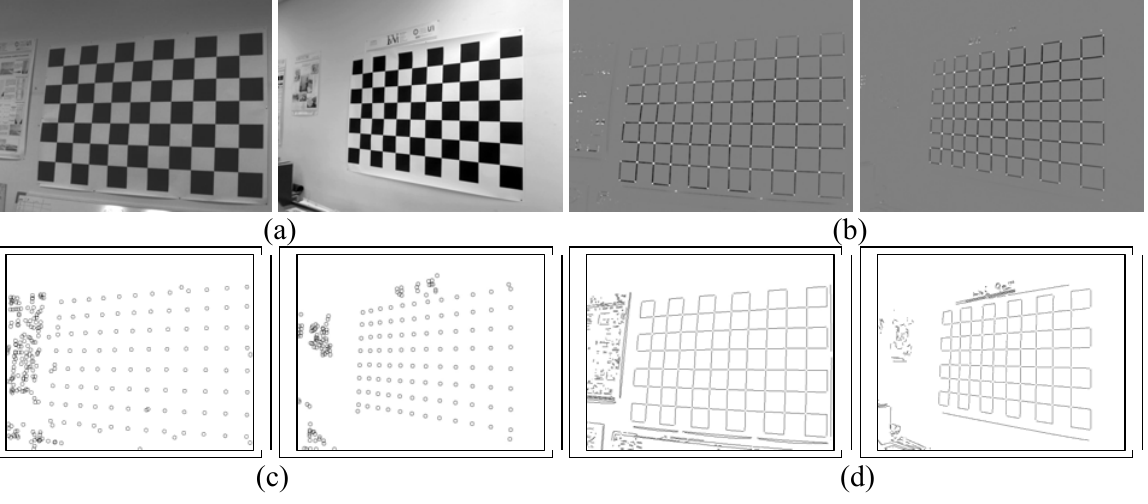
Figure 2. Harris corner detector (a) Original images (b) Harris operator (c) corner detection (d)